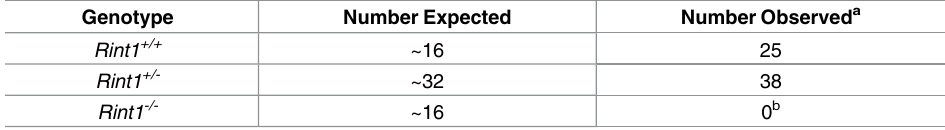
Table 3. Intercrossing B6. Rint1 +/- mice yields no Rint1 -/-